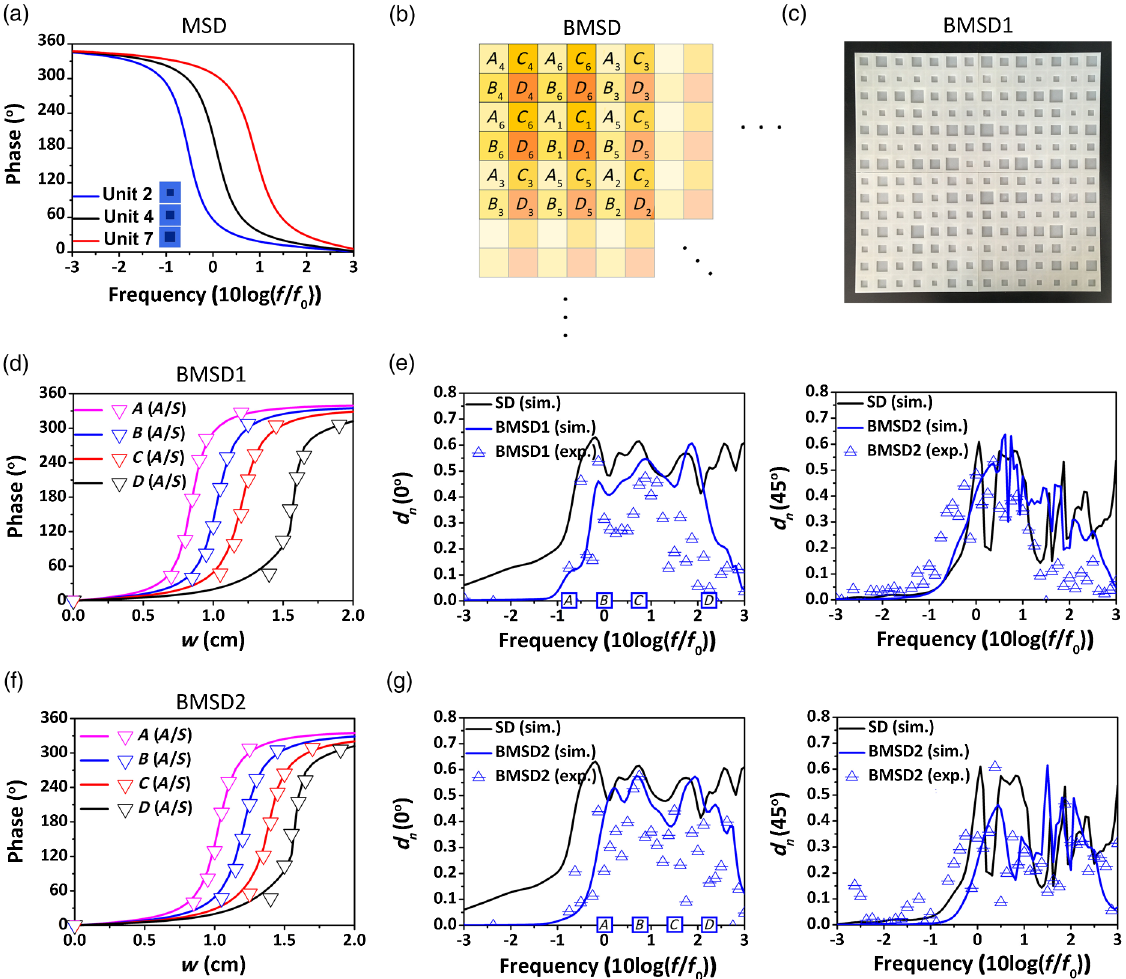
FIG. 5. (a) Phase profile of three selected unit cells of the MSD. Design of broadband metasurface-based Schroeder diffuser. (b) The QRS for a BMSD. A n , B n , C n , and D n represent four targeted frequencies. (c) Photograph of a 3D printed BMSD sample. (d) The analytical and simulated (A/S) relationship between the reflected wave phase and the parameter w for four frequency components for BMSD1. (e) Simulated and measured d 0 ;n (left) and d 45 ;n (right) in the x - z plane versus frequency for BMSD1 and SD, respectively. The corresponding results for BMSD2 are shown in (f) and (g). In (e) and (g), the center frequency is f 0 ¼ 6860 Hz. The four design frequencies of BMSD1 and BMSD2 are marked by squares A, B, C, and D in (e) and (g),